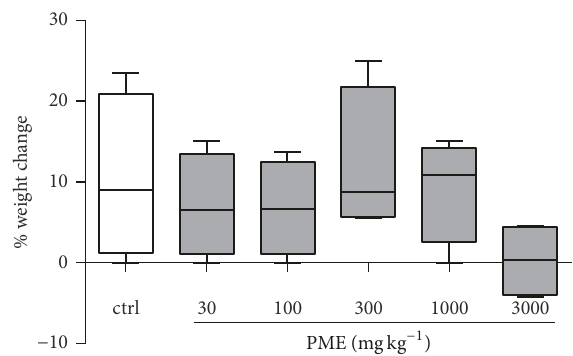
Figure 1: Effect of 14-day treatment with PME on the % change in body weights of rats in the subacute toxicity test. Data are expressed as mean ± SEM ( 𝑛 = 5 ). Treated groups were compared to controls with a one-way ANOVA followed by Newman-Keuls’ test. The lower and upper margins of the boxes represent the 25th and 75th percentiles, while the extended arms represent the 10th and 90th percentiles,